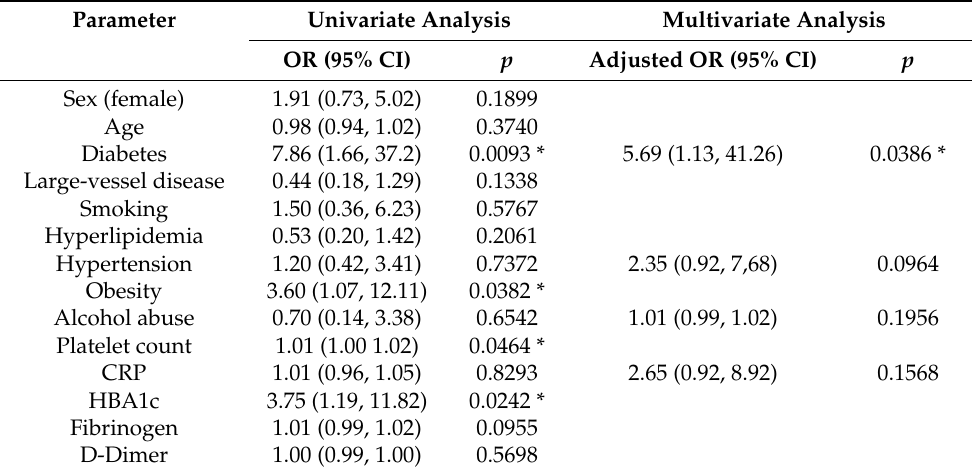
Table 2. Univariate and multivariate logistic regression analysis of predictors related to clopidogrel non-responsiveness.